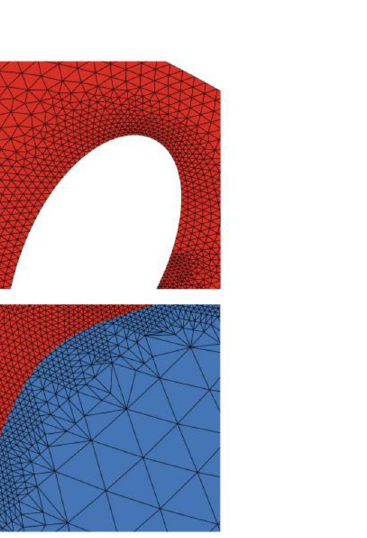
Fig 4. The utilized gird for computations (Grid 5) at t = 1750s (MVF = 0.75).